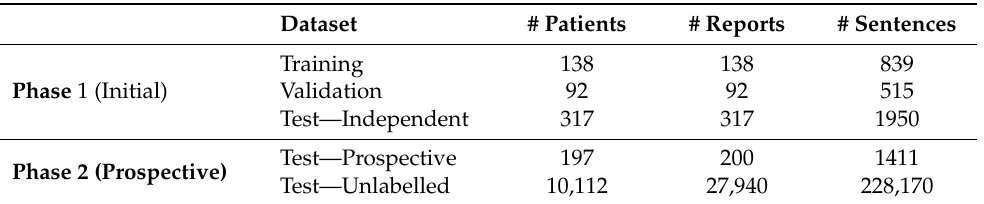
Table 1. Summary statistics for the NHS GGC datasets used in this work. The validation set is used for hyperparameter and best model selection.